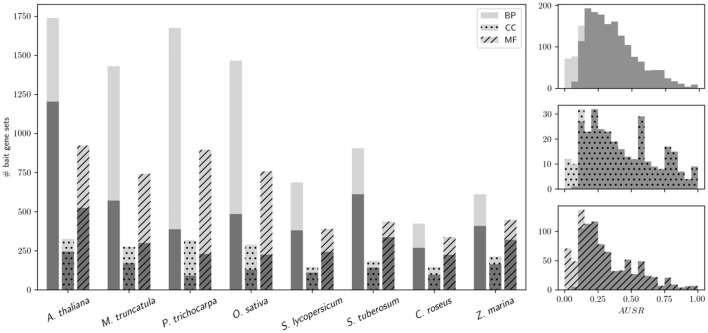
Performance of MORPH in bulk mode for different GO sub-ontologies. (Left) MORPH bulk results partitioned by sub-ontology (BP, CC, and MF) for the different species under study are shown. Light gray: the total number of analyzed bait gene sets with MORPH; dark gray: the number of significantly scoring (p < 0.05) bait gene sets. (Right) Histograms of AUSR values for different sub-ontologies in A. thaliana (using the same colors as in the left plot).